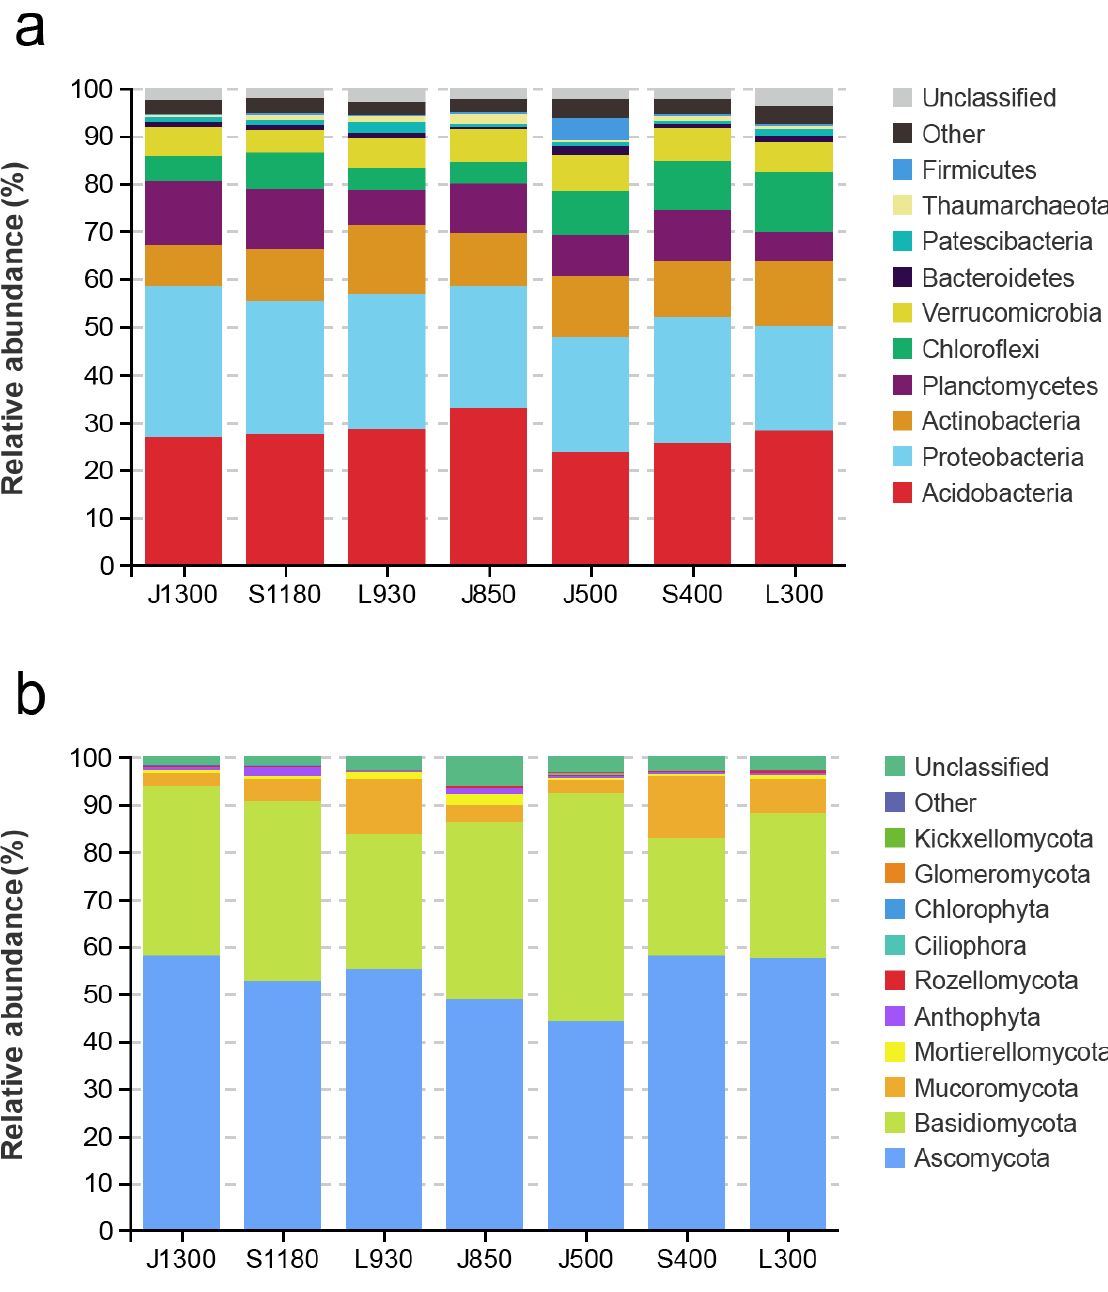
Figure 5. Relative abundance of bacterial ( a ) and fungal ( b ) phyla in different forest soils at different elevations.